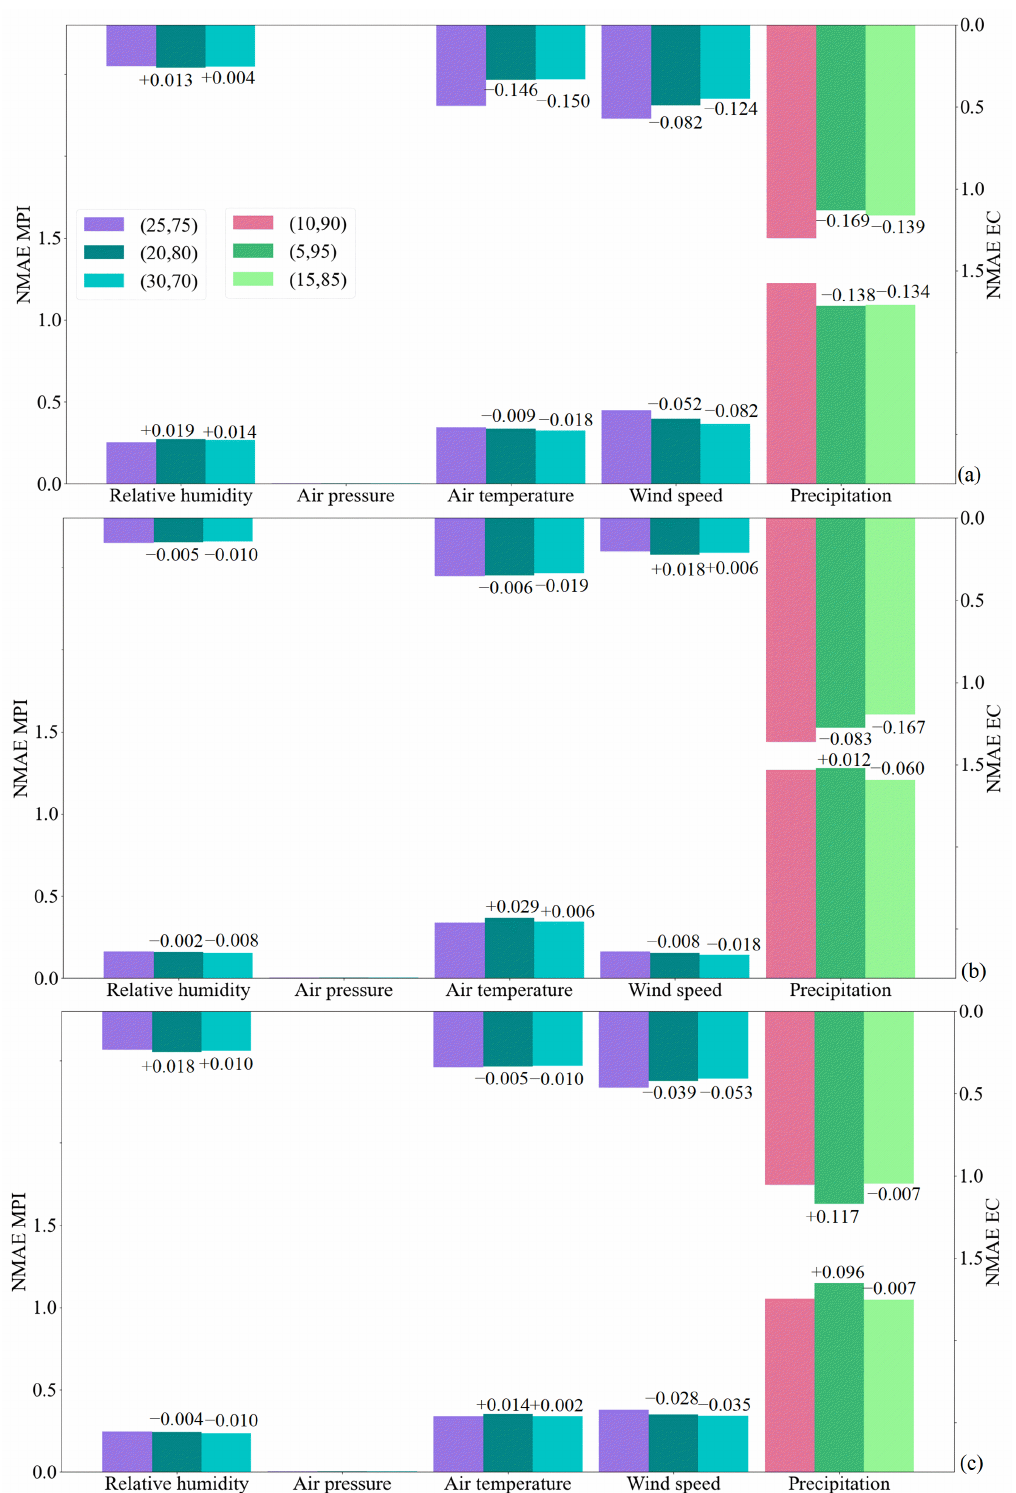
Figure 7. Bar chart showing the changes in NMAE of the calibrated results of the first adjustment (1985–1999) using different pairs of percentiles at the sites of Naqu ( a ), Wushaoling ( b ) and Shiquan River ( c ). The left y-axis devotes to the MPI and the right y-axis to the EC data. The number appearing above or below a bar indicate the change in NMAE value of this percentile pair relative to the default pair ((10,90) for precipitation and (25,75) for the rest). The NMAE values for air pressure are all very close to zero, such that they are not clearly depicted. Note that extreme events were not excluded when processing precipitation. N = 180 on each site.